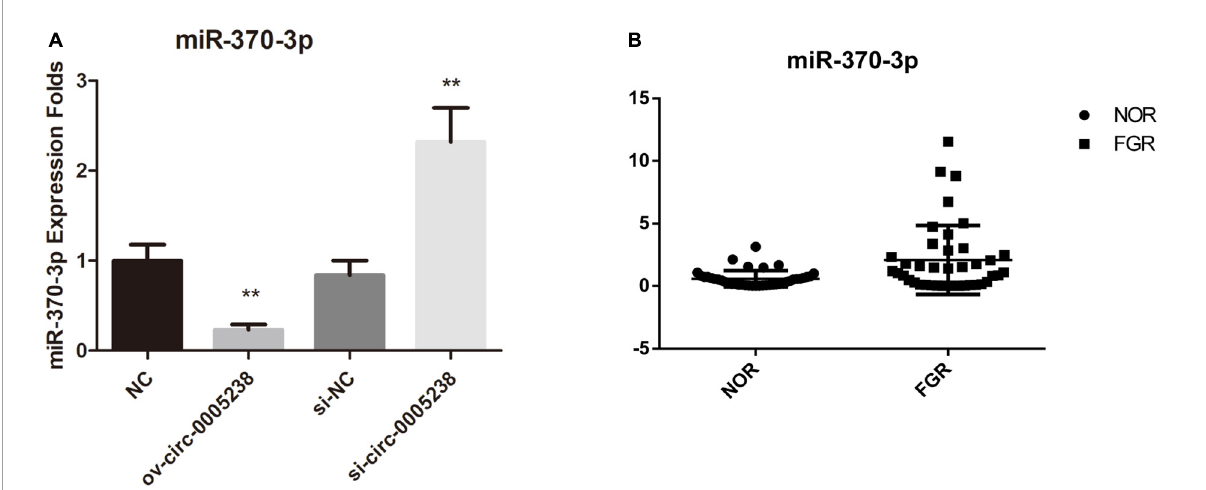
FIGURE5 Expression of hsa-miR-370-3p in the ov-circ-0005238, si-circ-0005238 group, and FGR placenta. (A) Expression of miR-370-3p in ov-circ-0005238, ov-NC, si-circ-0005238, and si-NC group. (B) hsa-miR-370-3p expression in FGR or normal placental tissues ( n = 40). ** P <